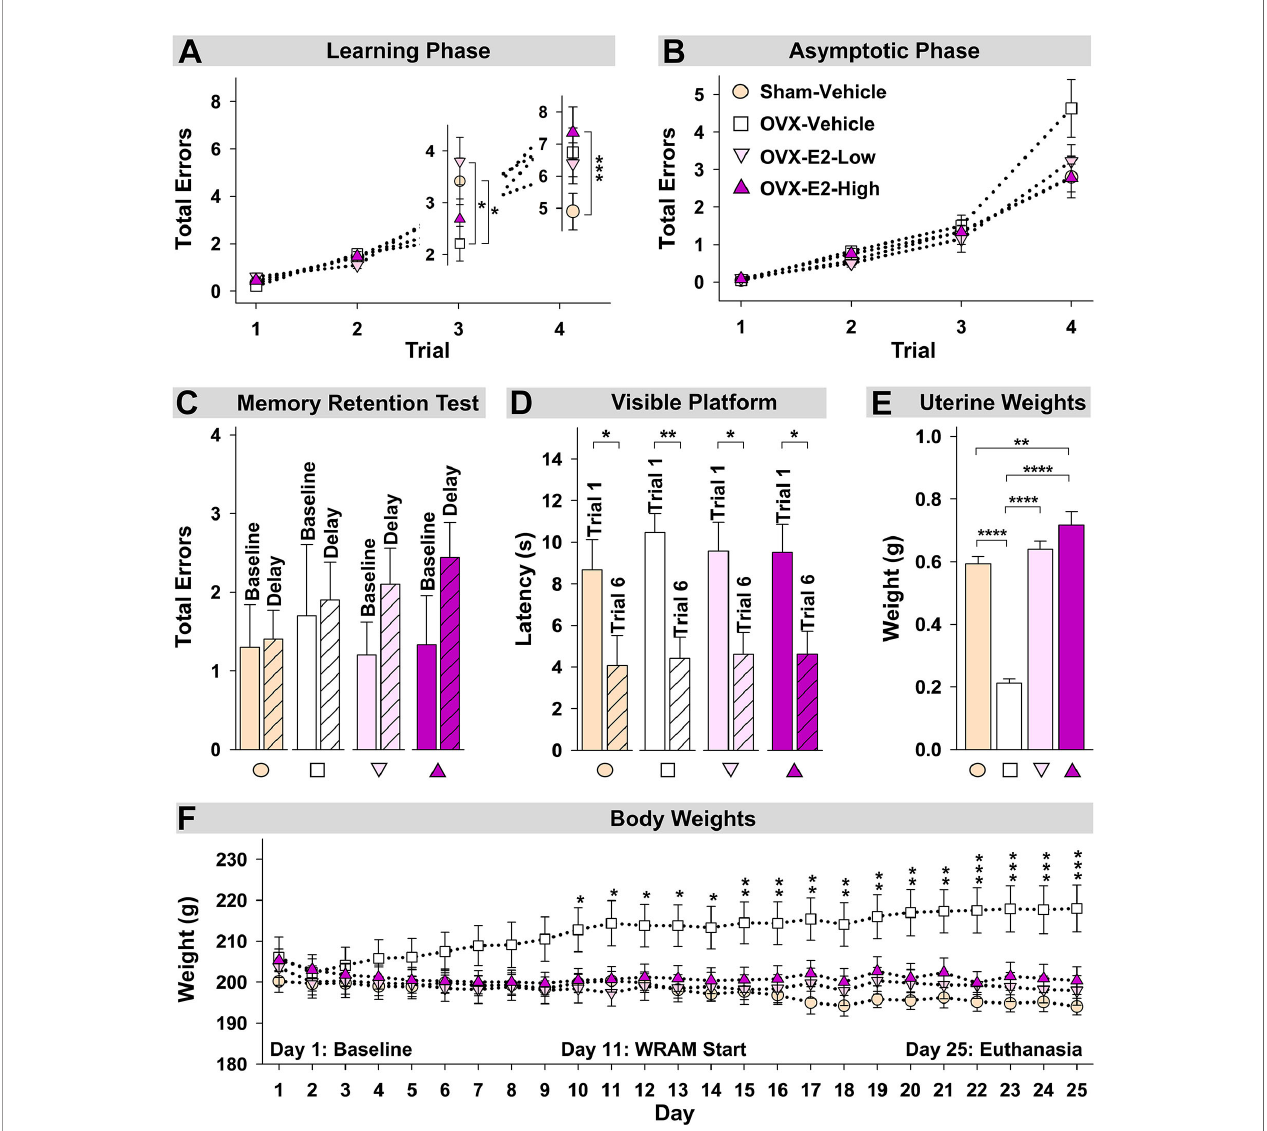
FIGURE 4 | Spatial memory and obesity markers. (A) During the Learning Phase, Trial x Treatment interactions suggested that as trials increased, patterns of group performance changed. On Trial 3, the OVX-Vehicle group showed enhanced performance compared to the Sham group and compared to the OVX-E2-Low group, while on Trial 4, the ovary-intact Sham group outperformed the Ovx-E2-High group and tended to outperform the OVX-Vehicle and OVX- E2-Low groups, indicating an OVX-induced impairment at the maximum working memory load that E2 treatment did not attenuate. (B) By the end of WRAM testing, all subjects performed similarly across trials. (C) Each treatment group was not impaired following a four-hour delayed memory retention trial. (D) Each treatment group decreased latency to the visible platform from the fi rst to last trial, indicating swimming, motoric, and visual competency. (E) OVX-Vehicle rats had decreased uterine weights compared to all other groups, indicating that surgery-induced estrogen loss results in a lack of uterine stimulation; E2 treatment after OVX successfully stimulates uterine tissue to that of ovary-intact rats. (F) Body weight increased in OVX-Vehicle rats beginning 10 days after surgery and remained elevated until the end of the experiment compared to all other groups. Group abbreviations (e.g., Sham-Vehicle) are described in Table 1 . Error bars indicate SEM. The asterisks indicate signi fi cant differences (*p ≤ 0.05; **p ≤ 0.01; ***p ≤ 0.001; ****p ≤